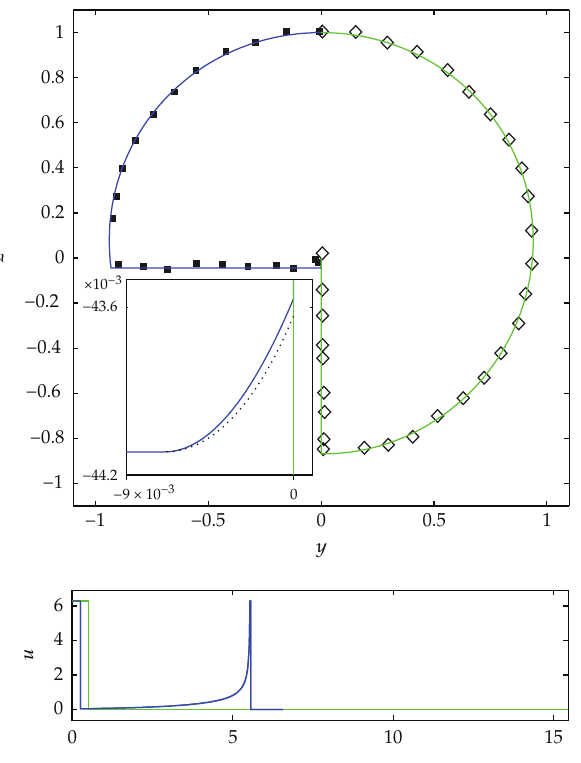
(cid:5) 740ms, T (cid:5) 60ms, and ω (cid:3) 2 π (cid:4) (cid:5) 32 . 3Hz. The 1 2 max /